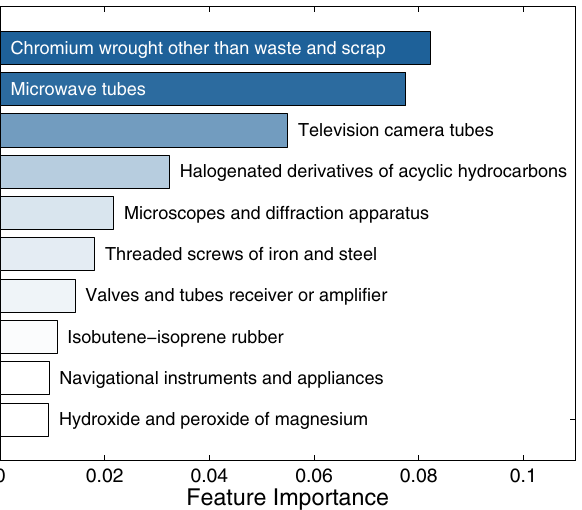
Figure 7. Feature importance is a measure of how much a product is useful to predict the activation of the target product. Here we use the average reduction of the Gini impurity at each split. All important products are reasonably connected with the